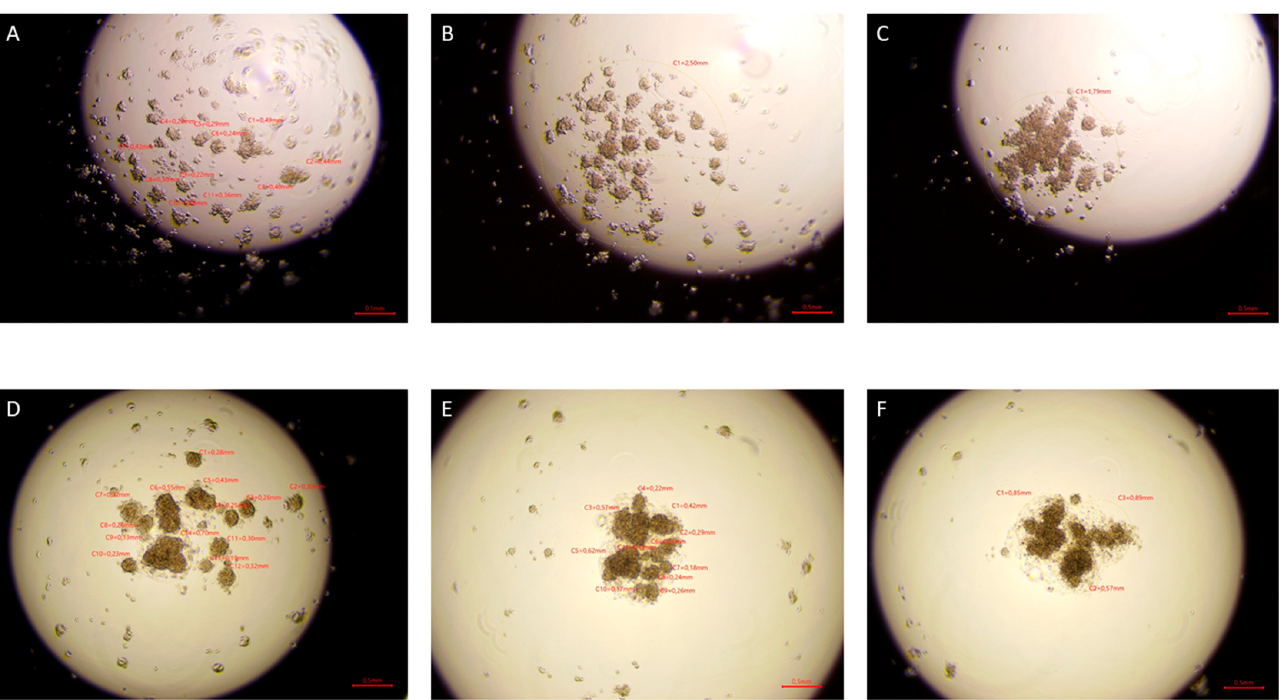
Figure 7. Caki1 cells in hanging drop culture. ( A – C ) show Caki1 cells from the control group 24, 48, and 72 h from the start of the culture, respectively. ( D – F ) show Caki1 cells exposed to 4.5 mT, 50 Hz EMF 24, 48, and 72 h from cultivation, respectively. Pictures taken with the Delta-Optical IB-100 microscope, 4 × magnification.